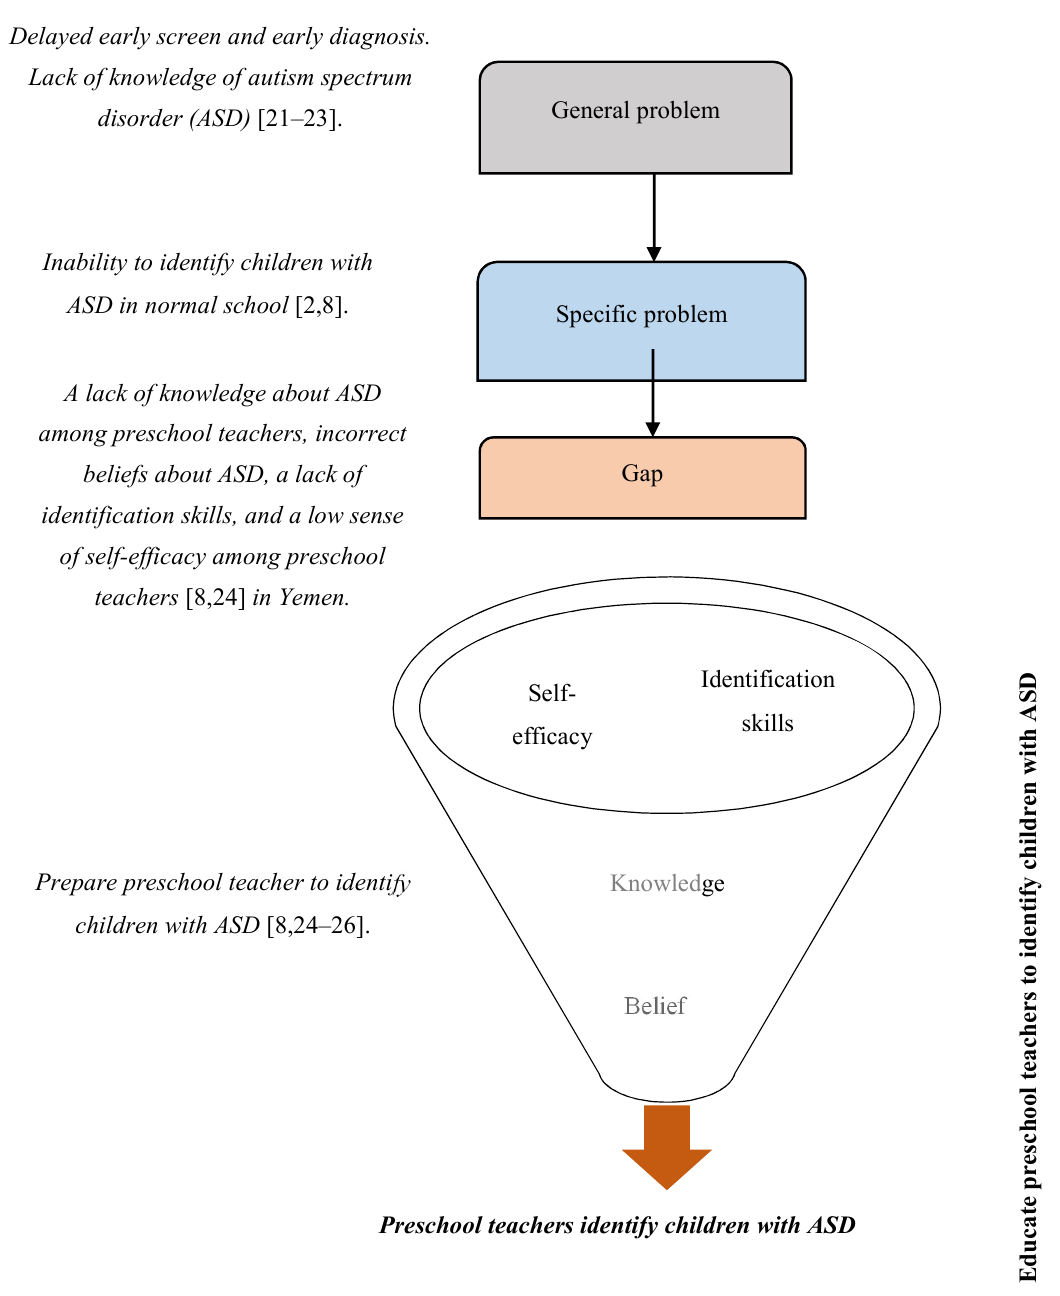
Figure 1. The research problem statement.